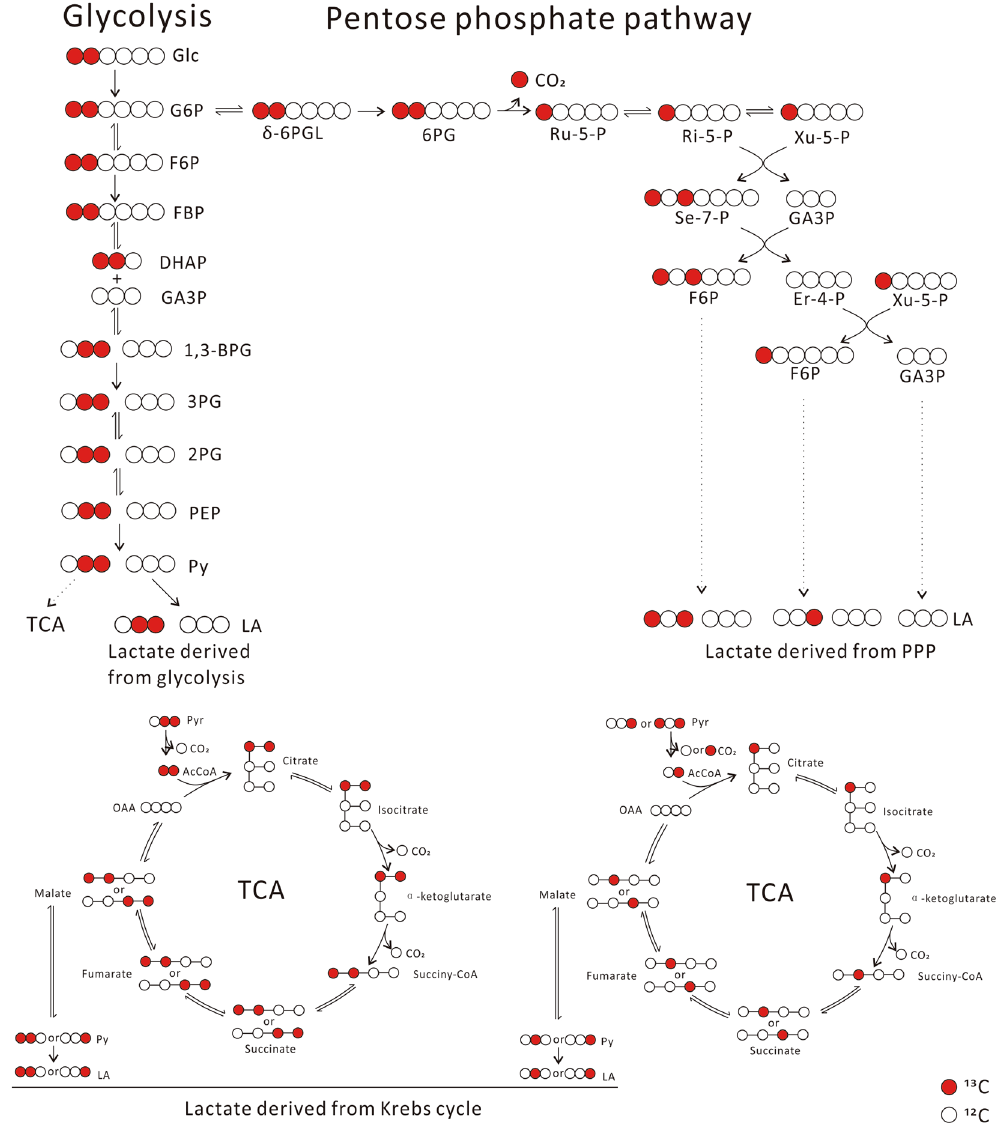
Figure 3. Metabolic pathways that generate various lactate isotopomers and isotopologues in cells, traced with [1,2- 13 C 2 ]glucose. 4T1 cells were incubated in serum-free RPMI 1640 medium containing 6 mM [1,2- 13 C 2 ] glucose for 12 hours in a humidified CO 2 incubator and culture supernatant was collected for LC-MS analysis as described in Materials and Methods. The figure explain the generation of various lactate isotopologues from [1,2- 13 C 2